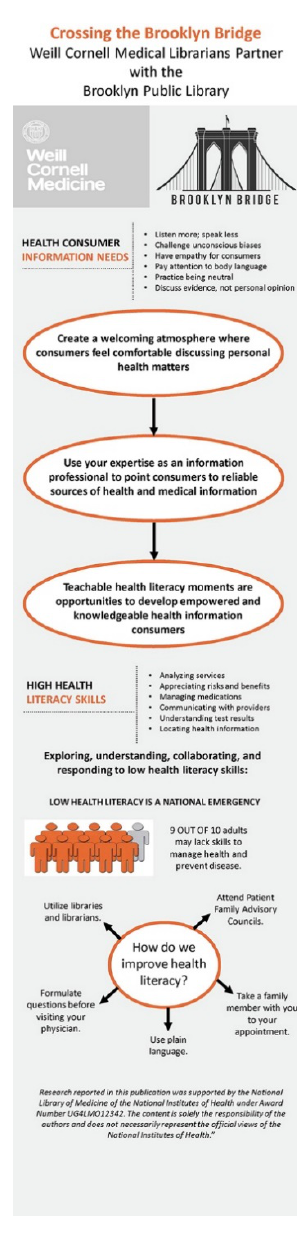
Figure 1 “ Crossing the Brooklyn Bridge”